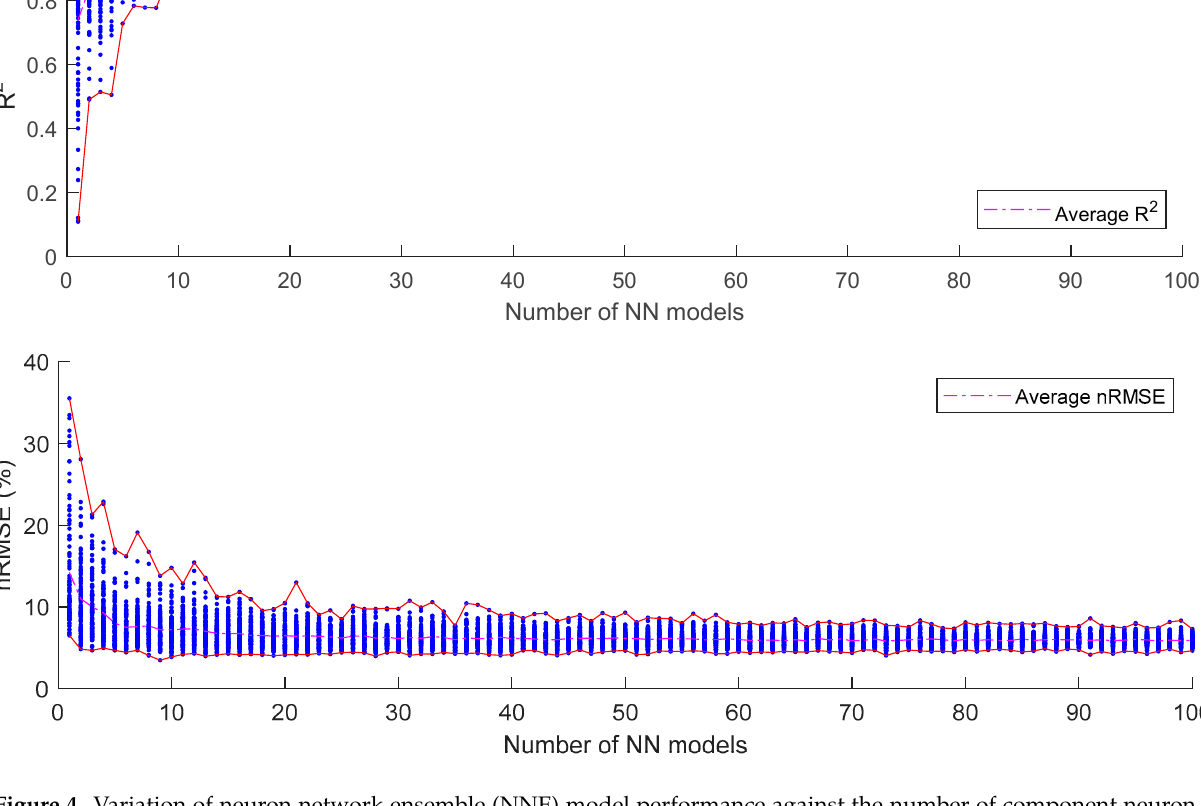
Figure 4. Variation of neuron network ensemble (NNE) model performance against the number of component neuron network (NN) models. Each dot represents the performance of an NNE model, and the valid and dash dot lines show the outline and average performance of the NNE models. R 2 is the determination coefficient; nRMSE is the normalized root mean square error.